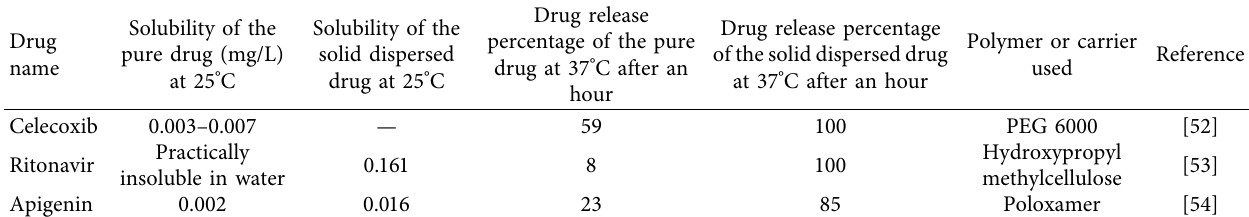
Table 6: Shows examples of decent case studies for the preparation of solid dispersion using the spray drying method. Solubility of Drug name